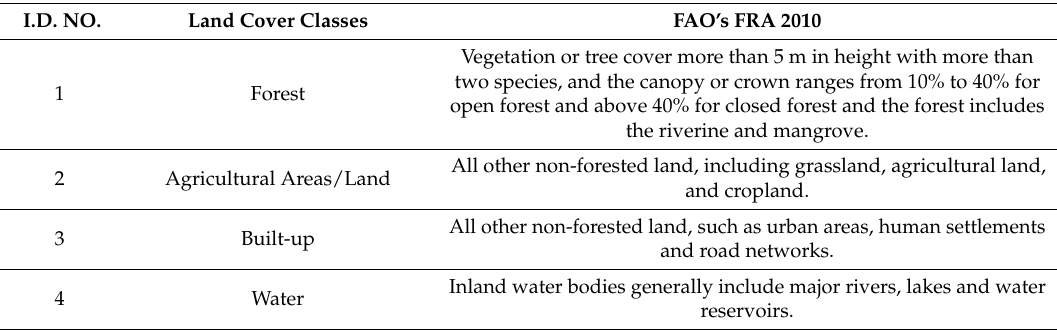
Table 3. Land cover classes and descriptions used in the study (Source: